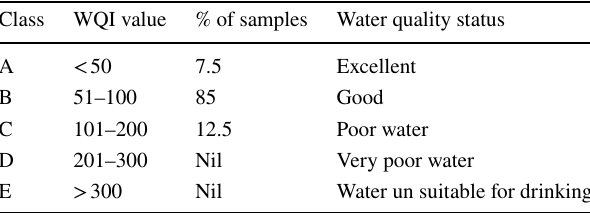
Table 6 Water quality classification based on WQI value